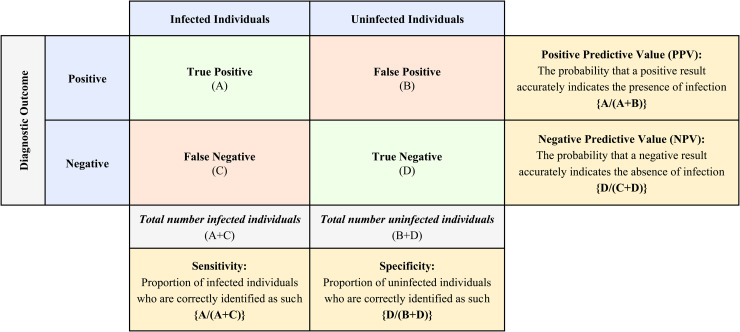
Defining sensitivity, specificity and predictive values (Akobeng, 2007; Bergquist et al., 2009).